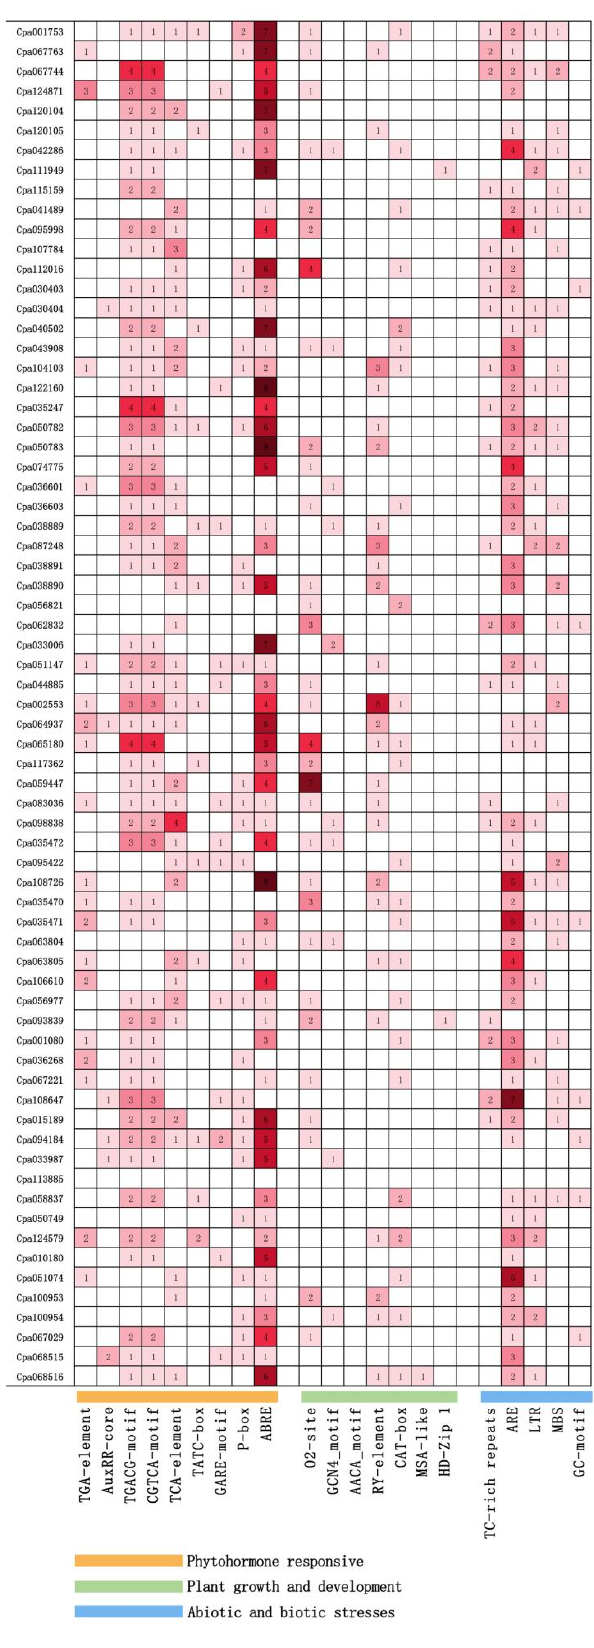
Figure 4. Cis-acting elements analysis of 69 CpaMYB genes in promoter region. Numbers in the squares showed the number of each cis-acting element in the promoter region. The darker the squares, the greater the number.